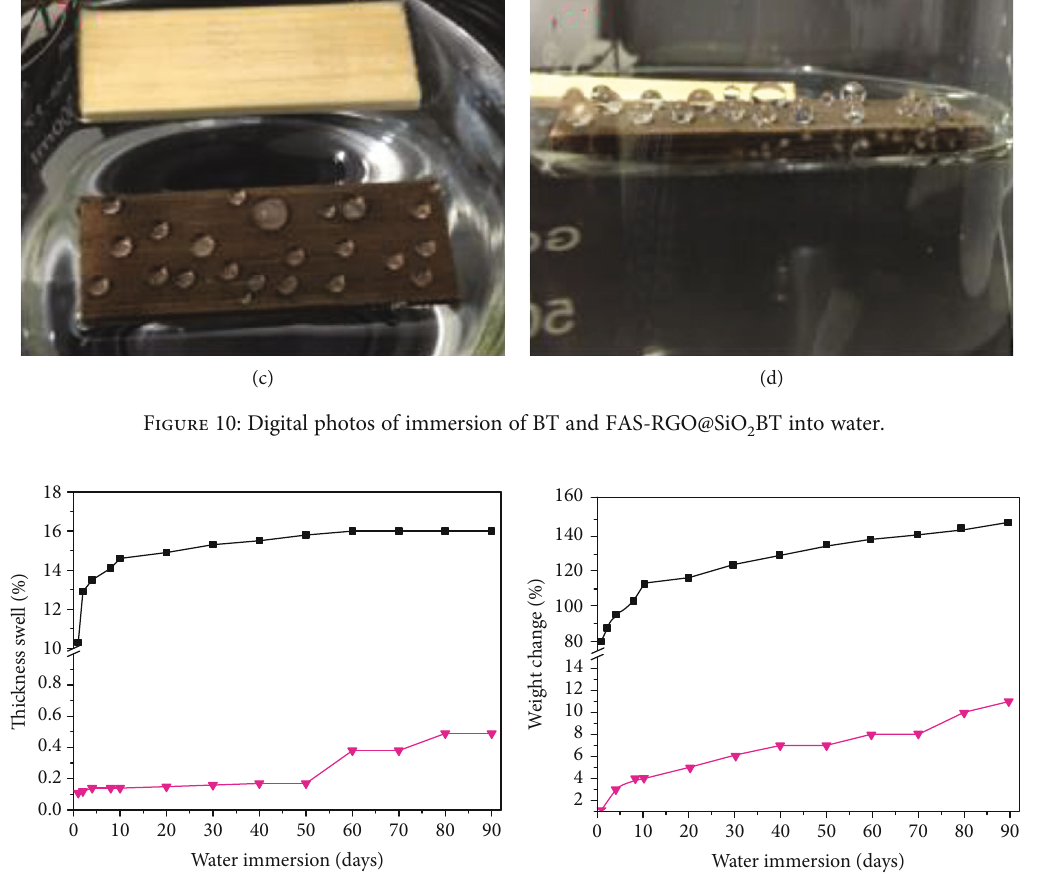
BT immersion in water for 90 2